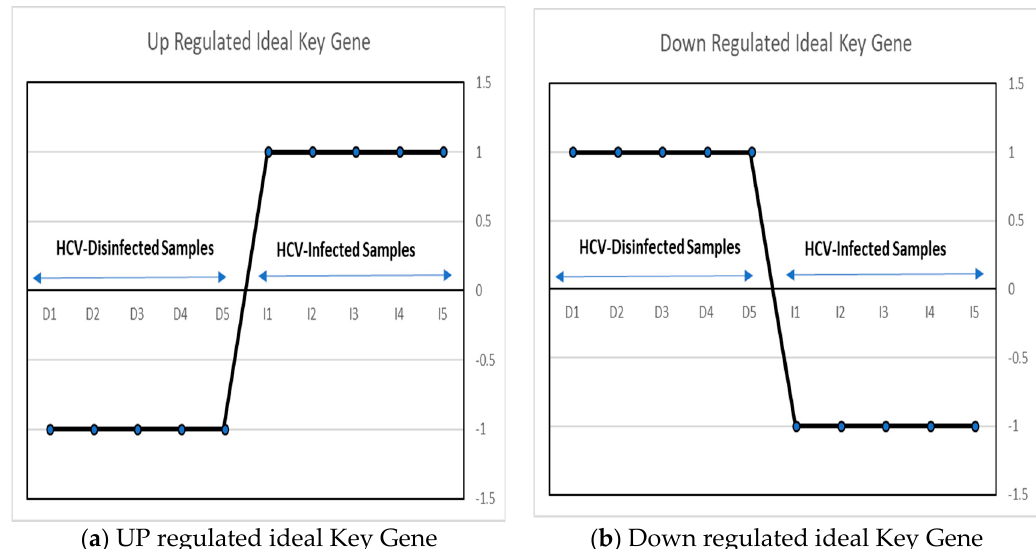
Figure 2. The proposed up/downregulated ideal key genes.